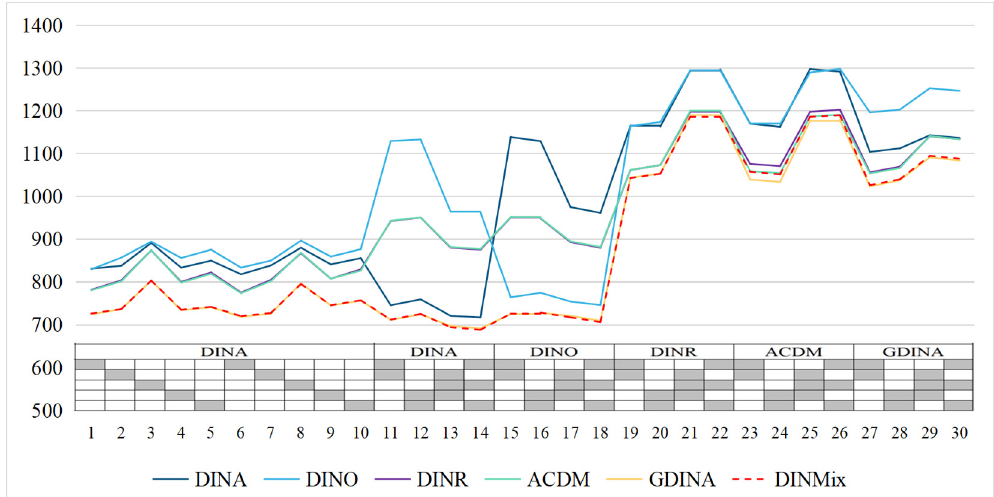
Figure 7. Item-level –2LCPO of six models in simulation Study 2. Note: The value is the mean value of 30 replications; –2LCPO = –2 log conditional predictive ordinate; DINA = deterministic input, noisy ‘and’ gate model; DINO = deterministic input, noisy ‘or’ gate model; DINR = deterministic input, noisy ratio model; ACDM = additive cognitive diagnosis model; GDINA = generalized DINA model; DINMix = deterministic input, noisy mixed model.